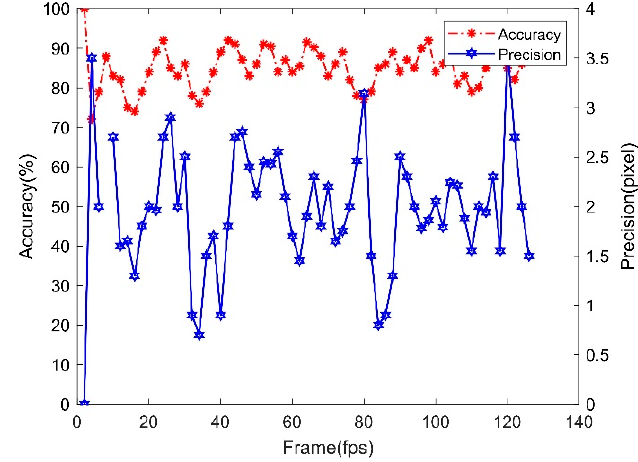
Figure 10. The tracking accuracy and precision of f.